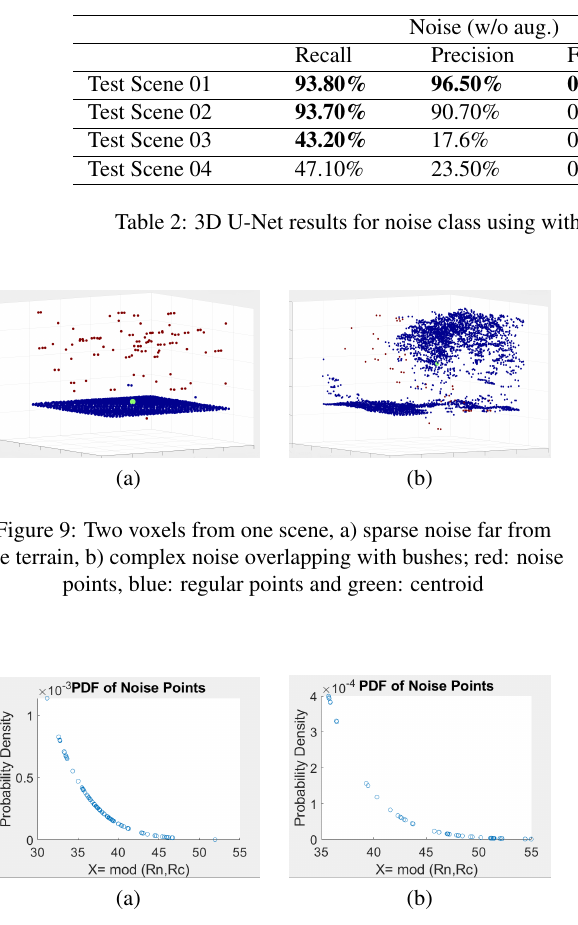
Figure 10: Normal distribution of noise points for voxels from